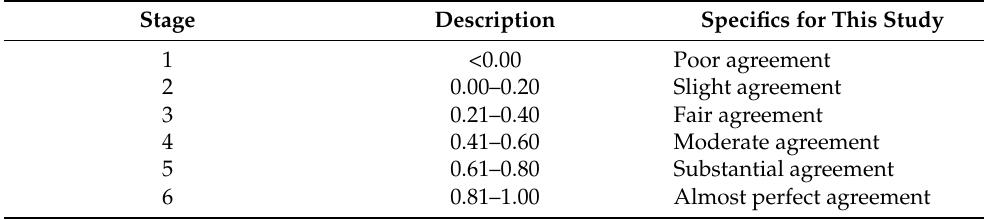
Table 4. Intercoder reliability coefficient